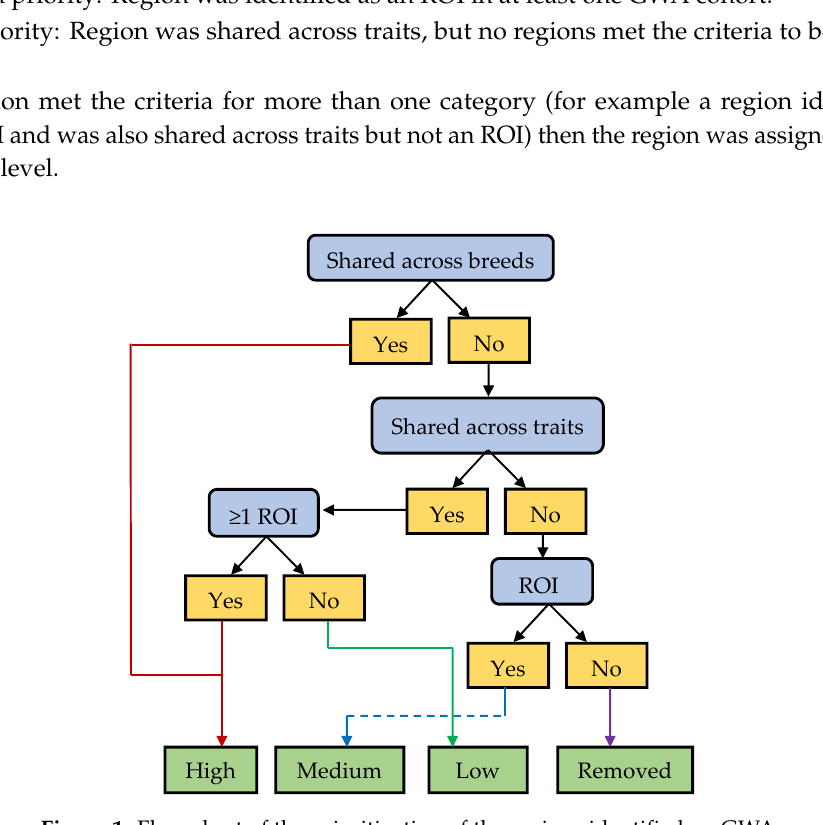
Figure 1. Flow chart of the prioritization of the regions identified on GWA.